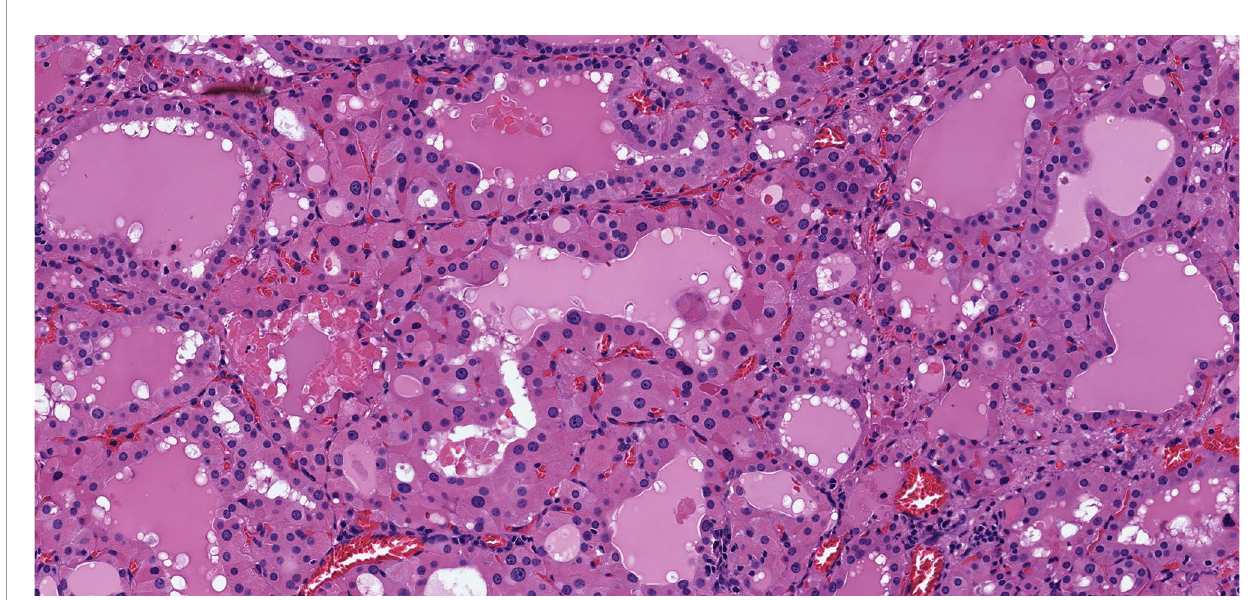
FIGURE 2 | Oncocytic Change in Graves ’ Disease. Graves disease is characterized by diffuse papillary hyperplasia with variable degrees of oncocytic change of the hyperstimulated follicular epithelial